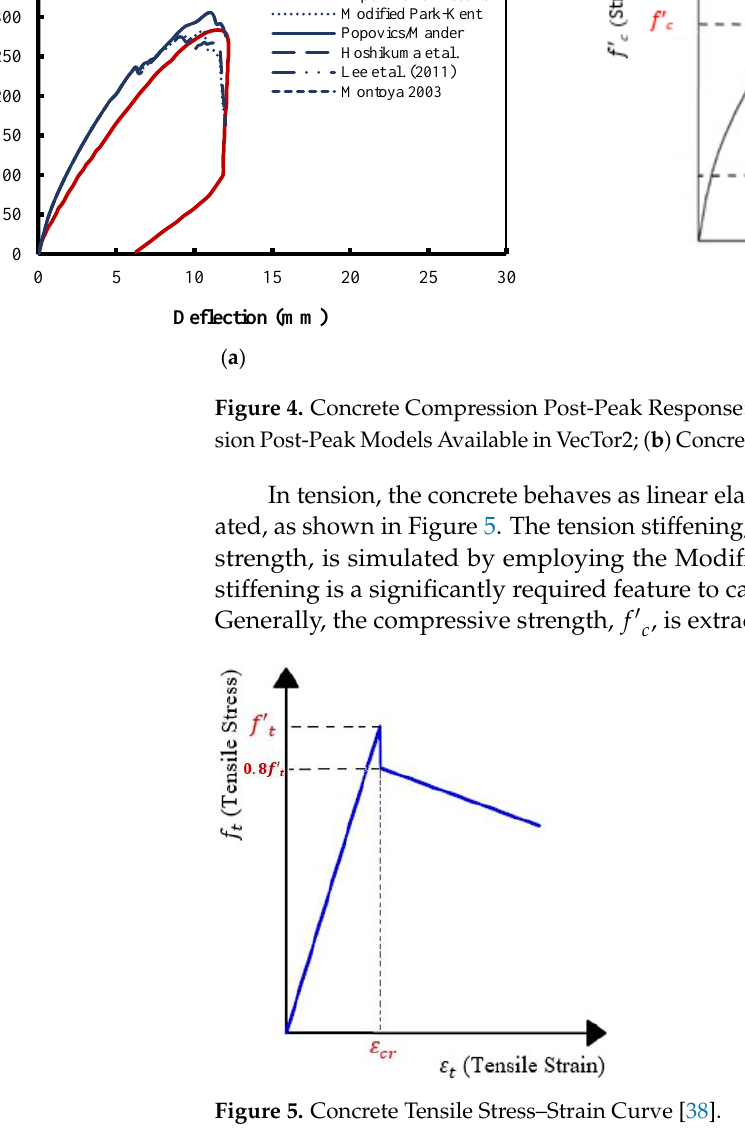
Figure 5. Concrete Tensile Stress–Strain Curve [38].